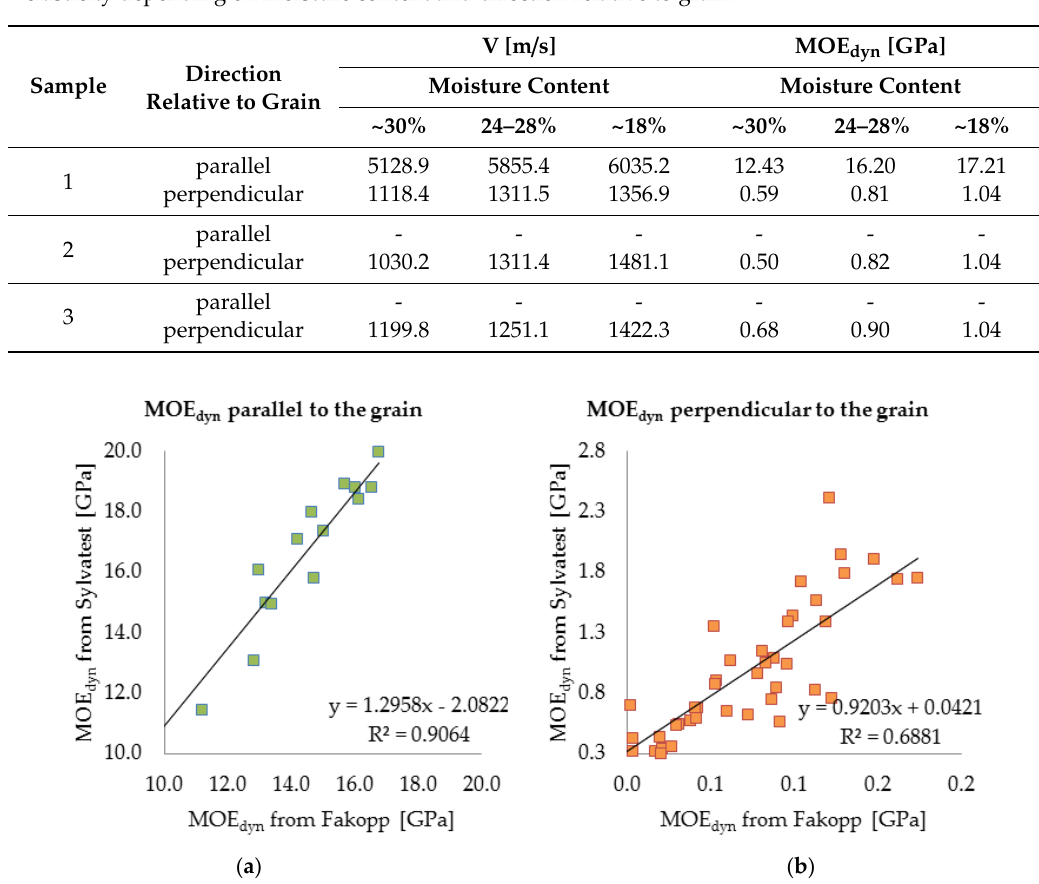
Table 10. Reconstruction parameters. Parameter